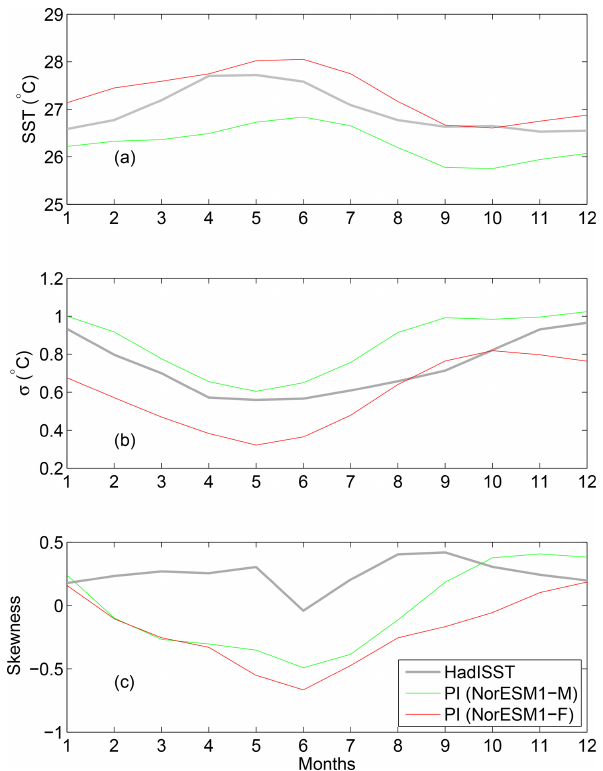
Figure 11. Monthly interannual (a) SST, (b) standard deviation of SST anomalies, and (c) skewness of SST anomalies in the NINO3.4 region for the PI control experiments (last 500 years) of NorESM1- F and NorESM1-M. Data from HadISST (averaged between 1900 and 2005) are also plotted for